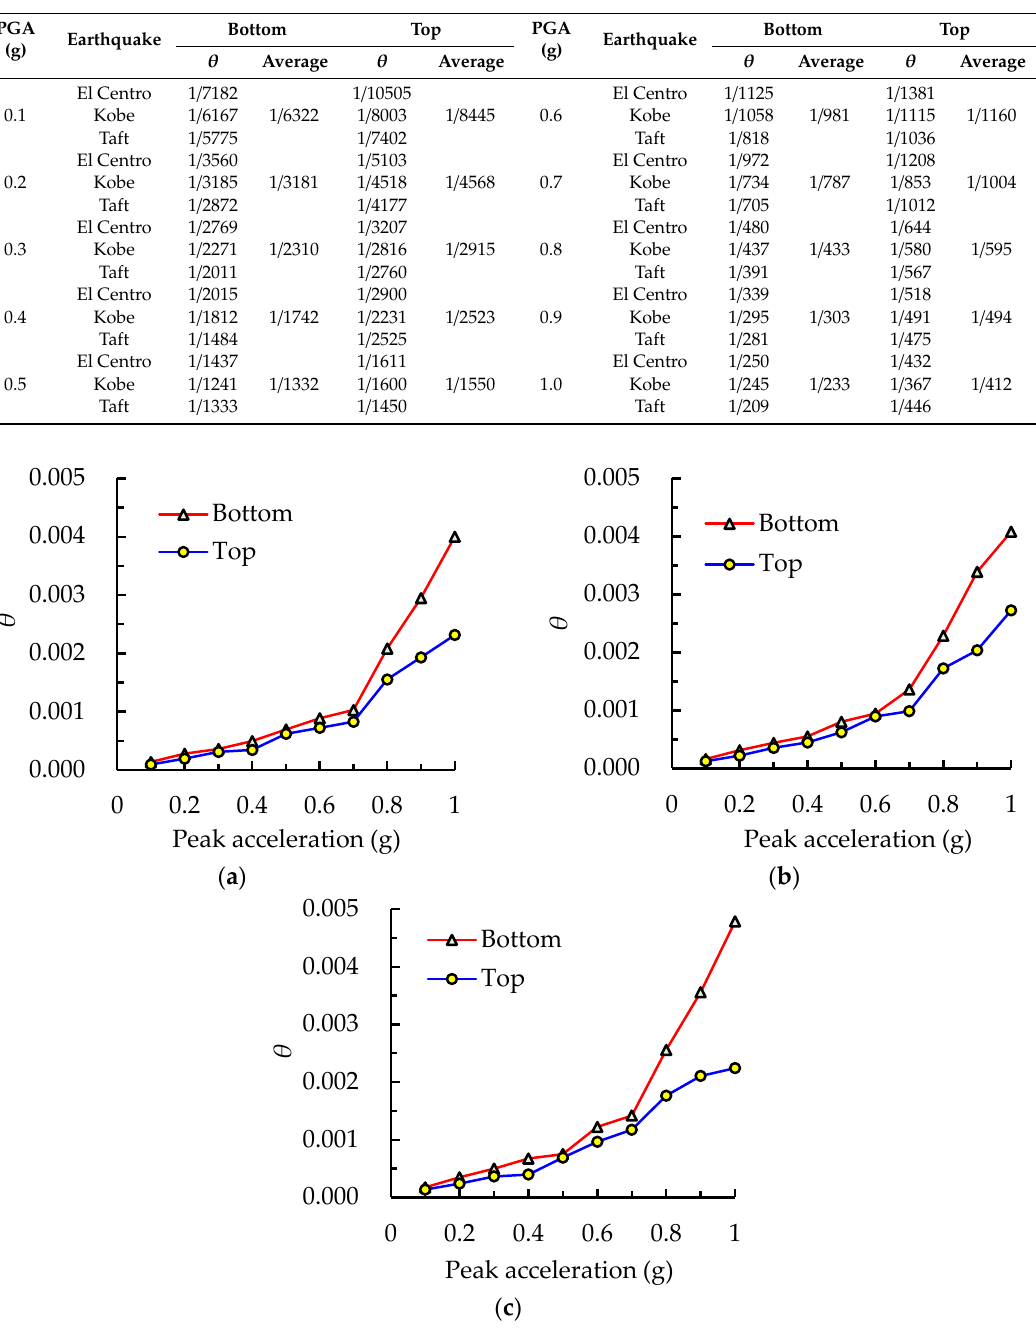
Figure 20. Maximum inter-story drift ratios versus loading peak accelerations for three seismic waves. ( a ) El Centro wave; ( b ) Kobe wave; ( c ) Taft wave.